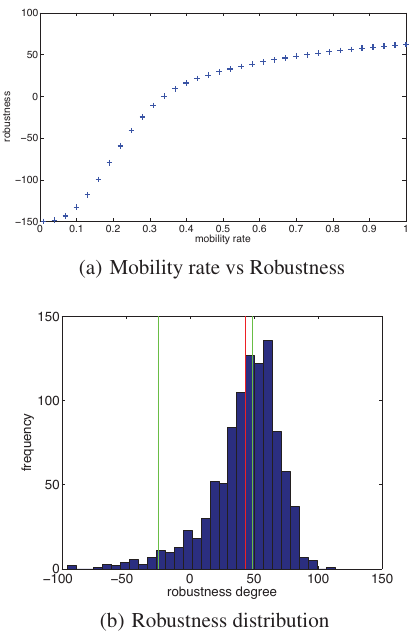
Figure 2: (a) Dependency of the robustness degree on the mo- bility rate (for the ODE interpretation of the model). (b) Em- pirical robustness distribution of the formula 3 with w 1 = 12 and w 2 = 15 and T inf = 5 , obtained from 1000 simulation